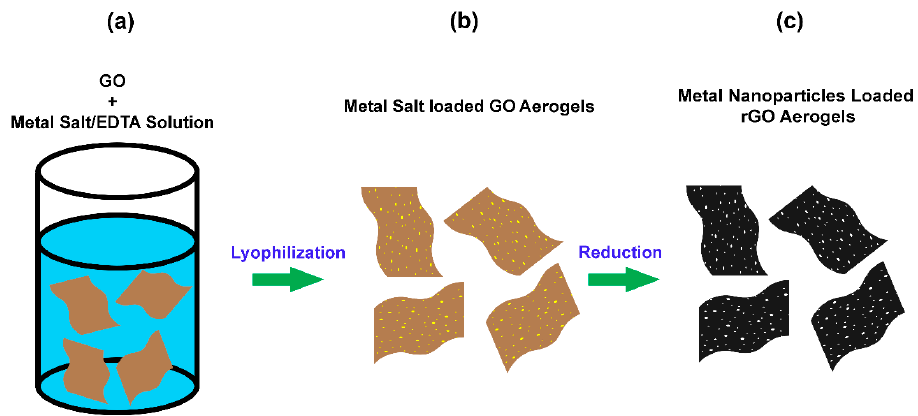
Figure 2. Schematic Illustration of the formation of metal nanoparticles decorated rGO aerogels. ( a ) GO + Metal Salt/EDTA Solution. ( b ) Metal Salt loaded GO Aerogels. ( c ) Mental Nanoparticles Loaded Rgo